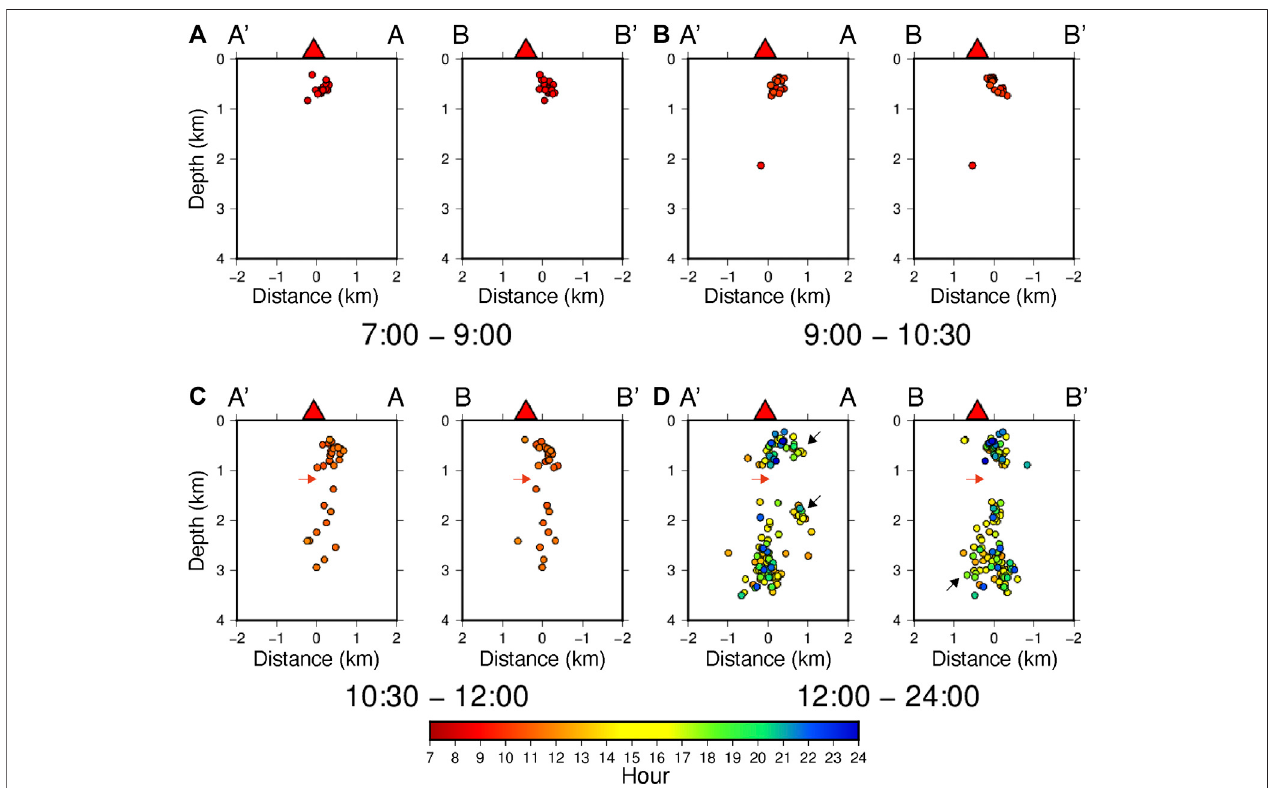
FIGURE9| HypocentersoftheVTearthquakesonAugust15,2015,projectedonthecrosssectionsA – A ’ (NE – SW)andB – B ’ (NW – SE),asshownin Figure8 .The colors indicate the occurrence time as Figure 7 . Red arrows show the depth of the center of the aseismic zone. The black arrows show the position of the tip of the expanded areaofthe hypocenter distribution. (A) Period from 7:00 to9:00 JST. (B) Period from 9:00 to10:30 JST. (C) Period from 10:30 to12:00 JST. (D) Periodfrom 12:00 to 24:00